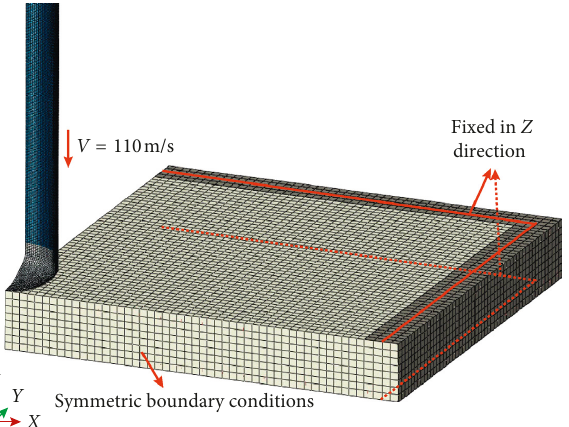
Figure 7: Finite element model of the impact simulation.